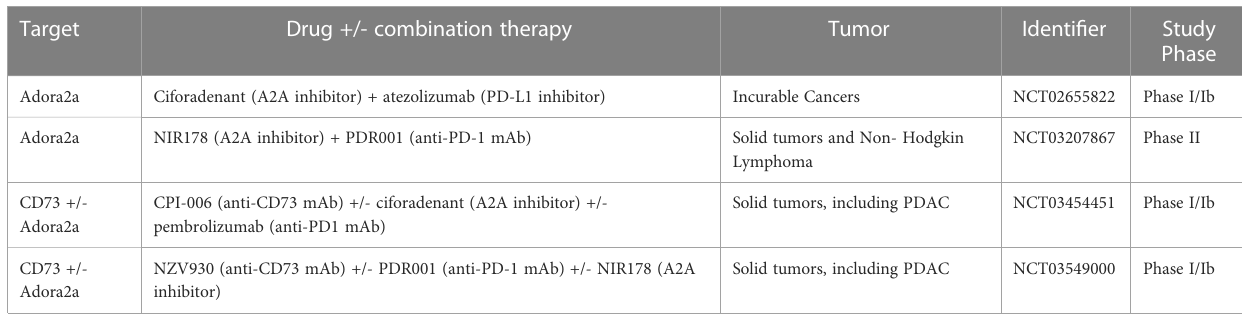
TABLE 1 Current clinical